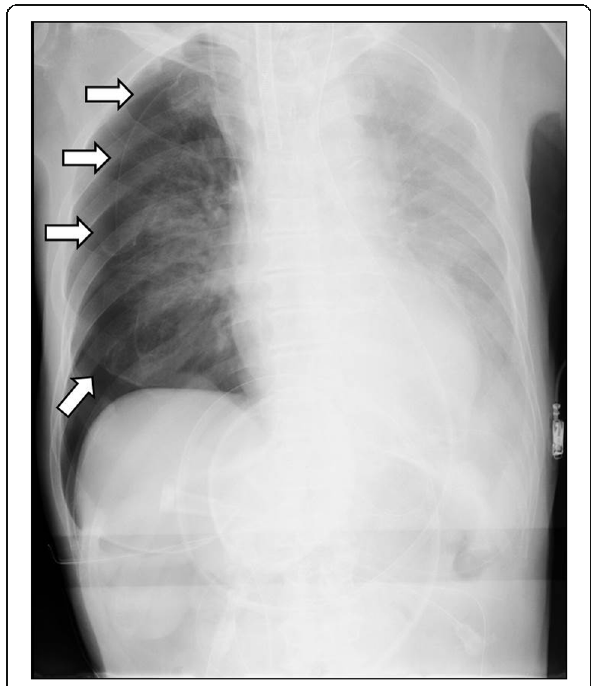
Fig. 2 Postoperative chest X-ray showed right pneumothorax ( arrows ). The decrease in radiolucency in the left chest is considered to be due to pleural